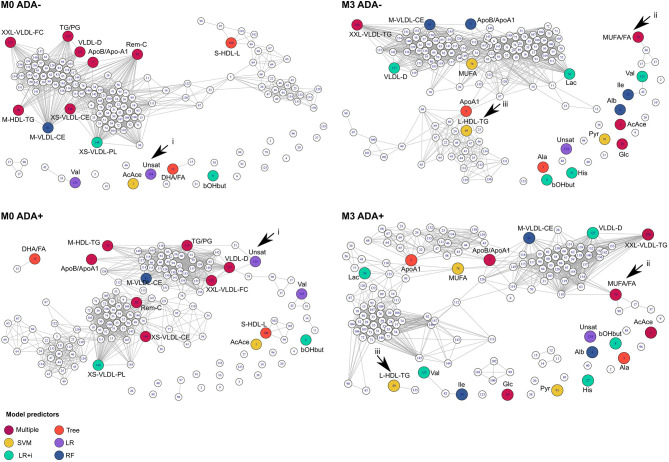
Connections between metabolites are different in ADA– and ADA+ patients. Relationships between metabolites in ADA– and ADA+ patients at baseline (M0) and month 3 (M3) are shown as network diagrams. Colored nodes represent the metabolites contributing to predictive models at each time point (see key “Model predictors”), as described in the methods section. Arrowheads point to key differences that are discussed in the main text.